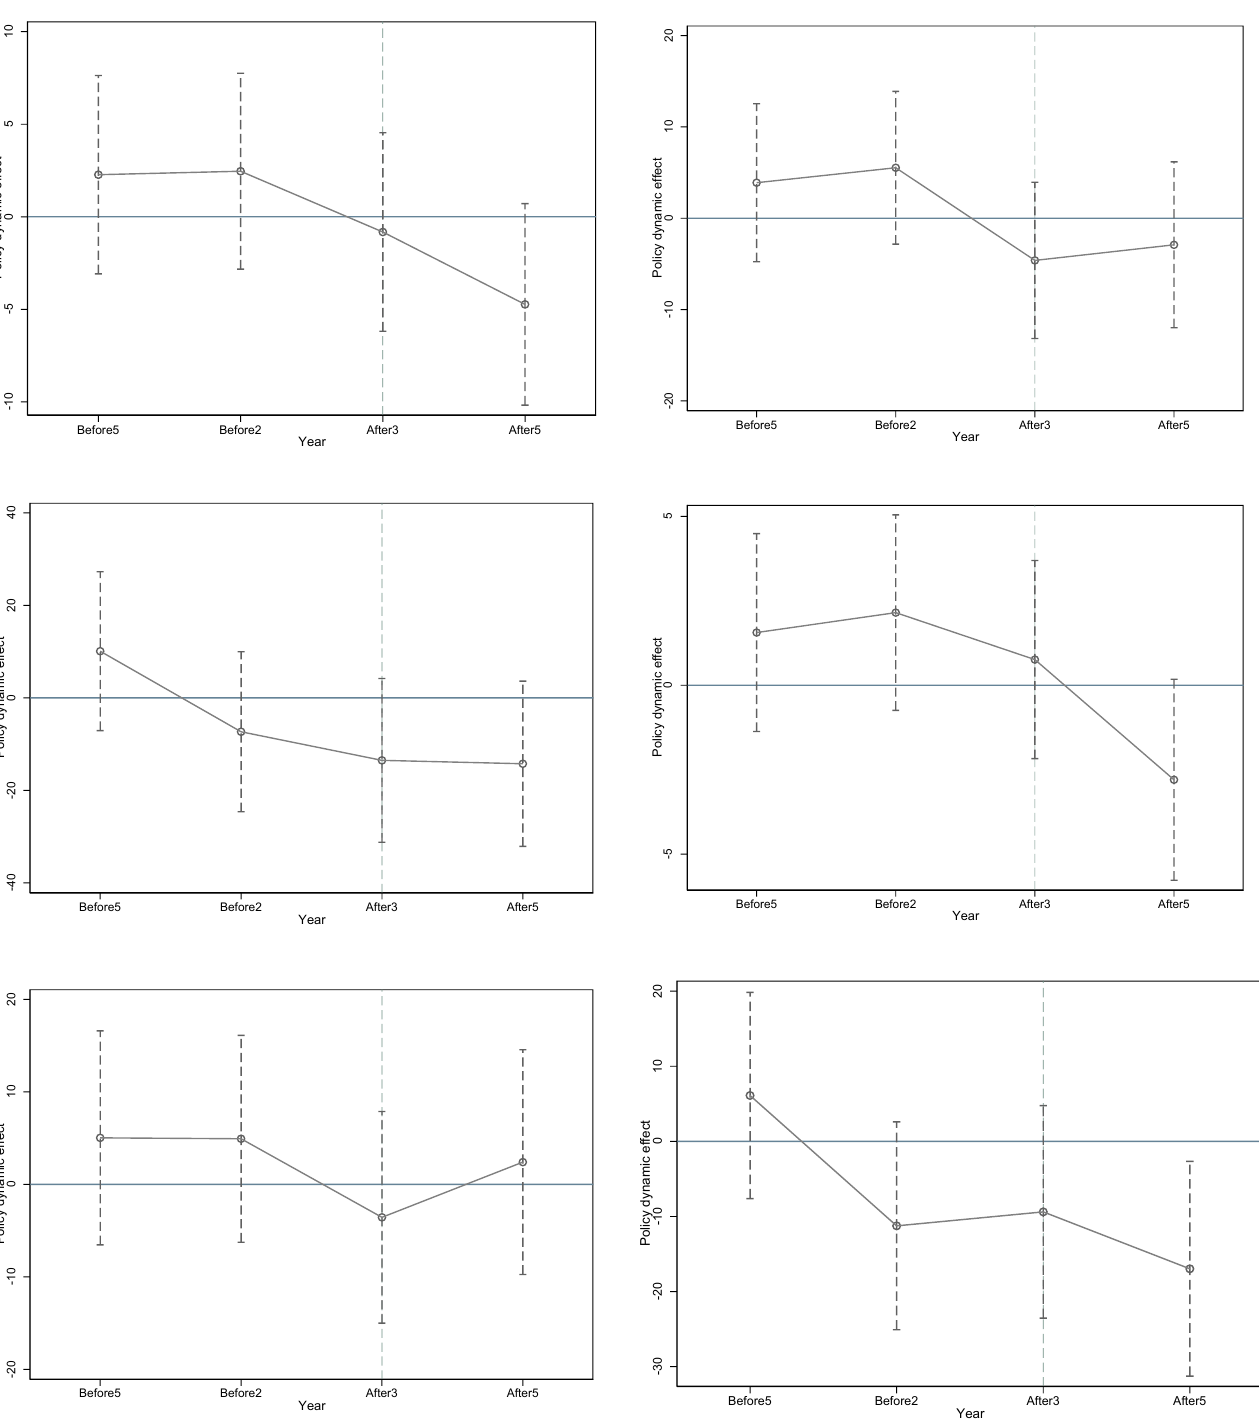
Figure 3. Parallel trend test: regression. The first three figures are the test results of the parallel trend of production-based carbon emissions of the chemical, building materials, and metal industries, respectively. The following three figures are the test results of the parallel trend of consumption-based carbon emissions of the chemical, building materials, and metal industries, respectively. Placebo Test